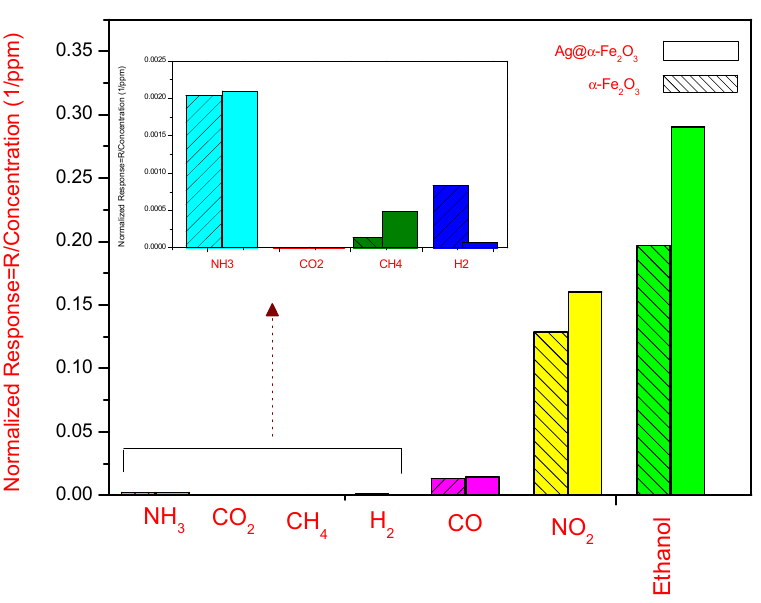
Figure 9. Normalized response of Ag@ α -Fe 2 O 3 and α -Fe 2 O 3 sensors at 250 °C. In the